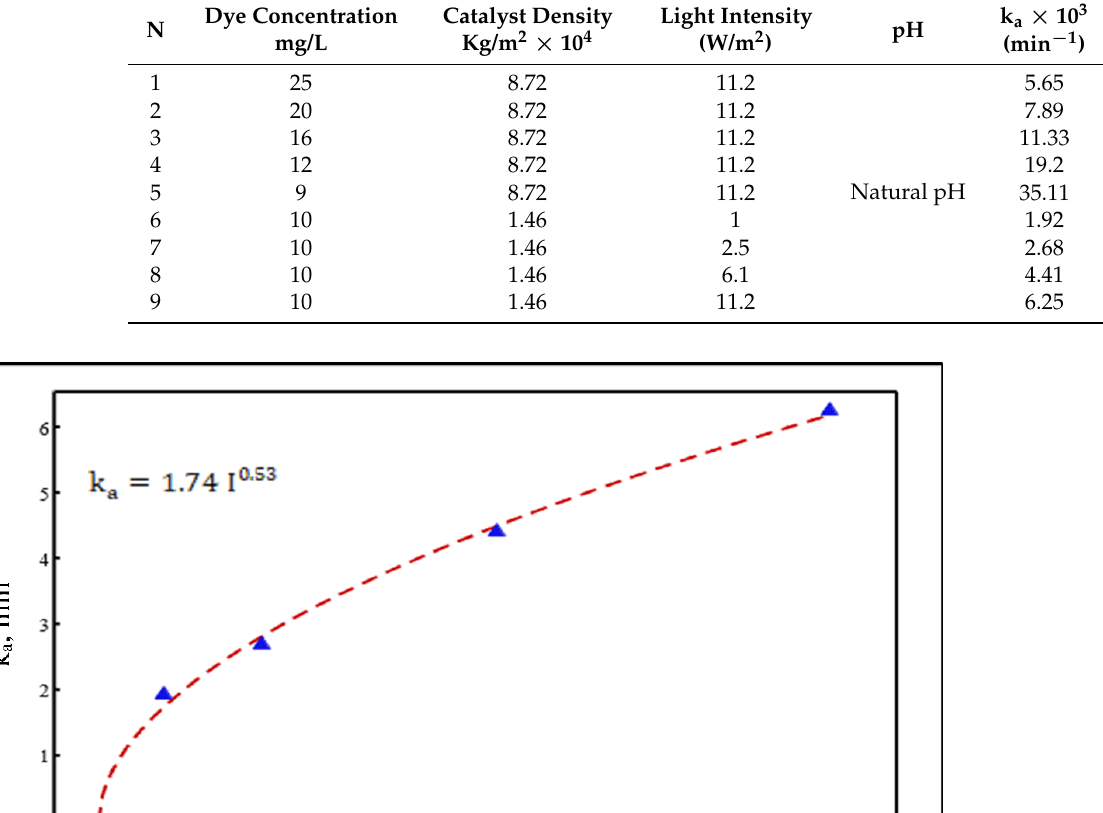
Table 8. Kinetics data obtained for catalyst P25 immobilization at different reaction conditions.